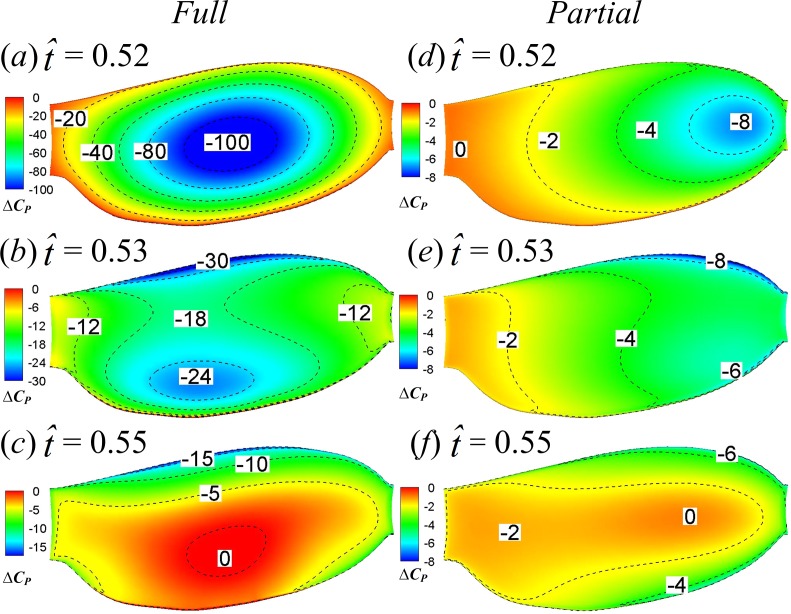
Upper-surface pressure differences between the two two-winged cases and the single-winged case at \documentclass[12pt]{minimal}
\usepackage{amsmath}
\usepackage{wasysym}
\usepackage{amsfonts}
\usepackage{amssymb}
\usepackage{amsbsy}
\usepackage{upgreek}
\usepackage{mathrsfs}
\setlength{\oddsidemargin}{-69pt}
\begin{document}
}{}$\hat {t}=0.52$\end{document}t ˆ=0.52, 0.53 and 0.55.